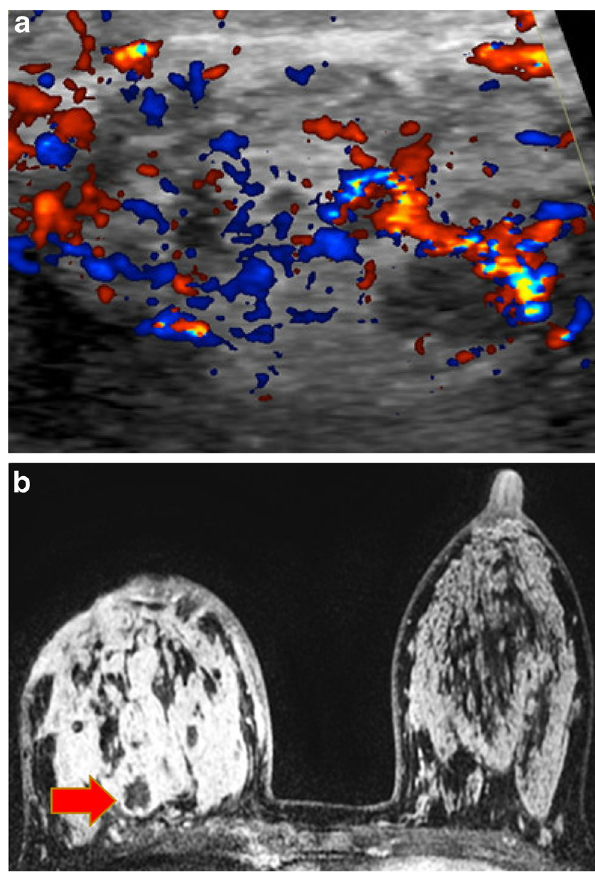
Fig.8 Infectiouscause: Corynebacterium . A 31-year-old pregnantwom- an had a red and swollen right breast. On ultrasound-guided biopsy and aspiration, Corynebacterium infection was identified. a Ultrasound of the right periareolar region demonstrates marked vascularity on colour Doppler with heterogeneous breast tissue and areas of hypoechogenicity consistent with micro-abscesses ( red arrow ). Appearances are identical to idiopathic granulomatous mastitis sonographically. b Axial contrast- enhanced MRI showed global asymmetry, skin thickening, and diffuse increased enhancement in right breast with non-enhancing areas consis- tent with small abscess collections ( red arrow )